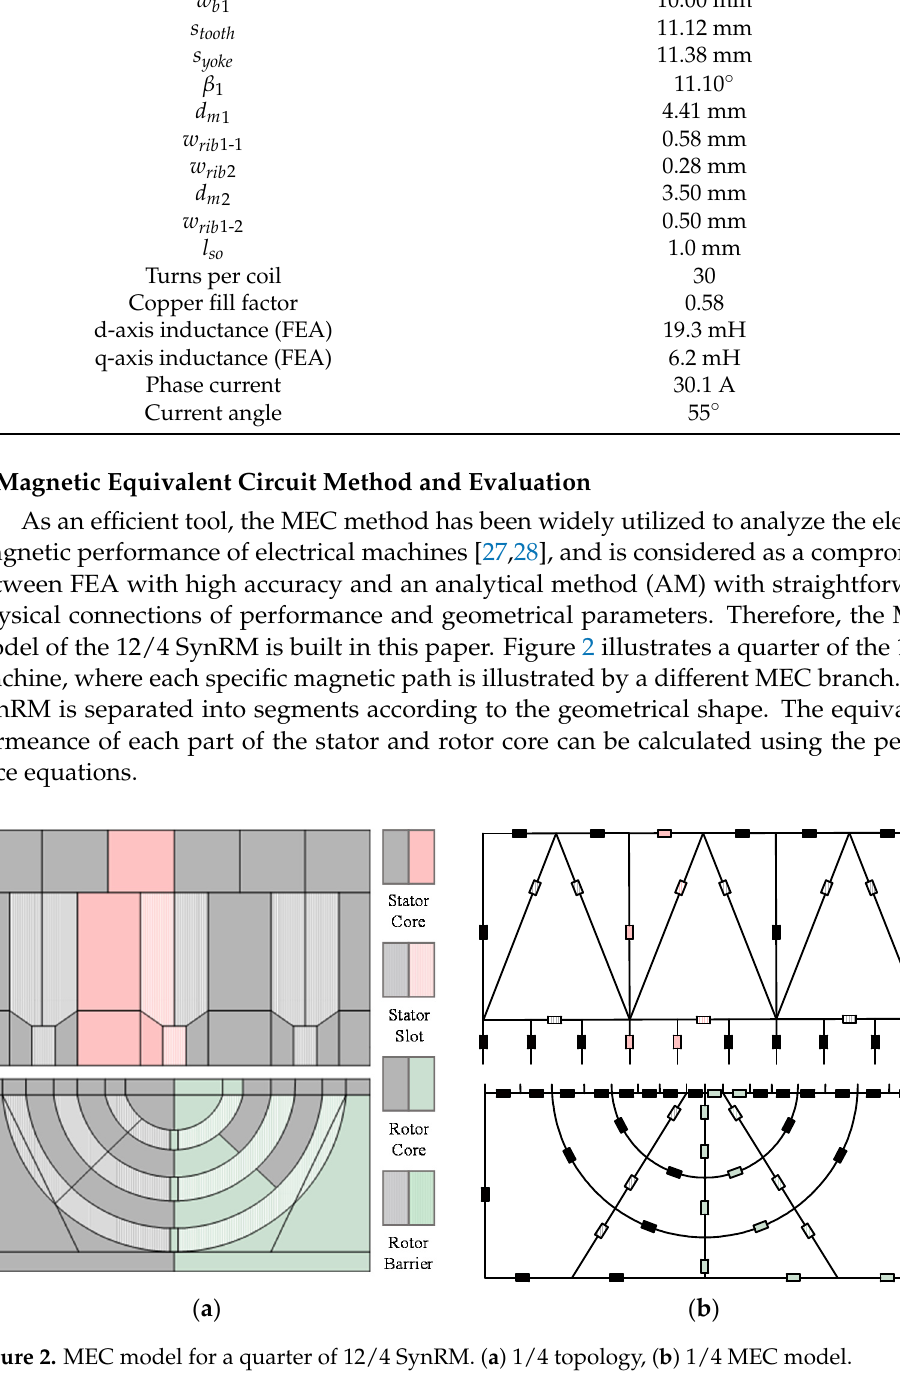
Table 1. Main Design Specifications of the 12/4 Machine.